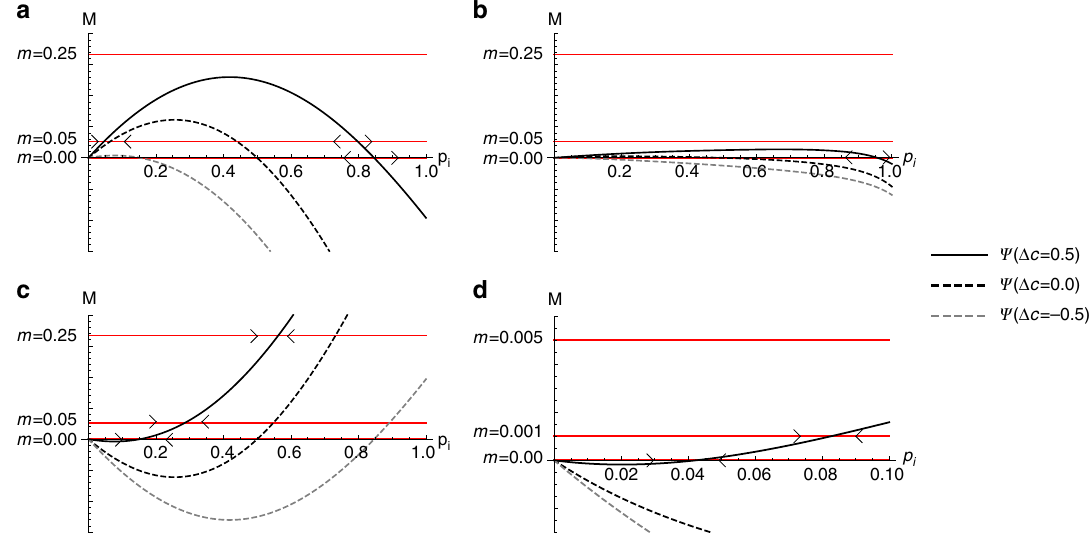
Fig. 4 Equilibrium structure for the scenarios of coordination and complementation. The payoff of a cultural trait increases with its perceived frequency for the coordination scenario ( a , b ) and decreases for the complementation scenario ( c , d ). a , c individuals are equally likely to interact with both types ( X ii = X = X = 1.0); b , d individuals are more likely to interact with individuals of the same type ( X rr ir (red) and the right-hand side (black) of the equilibrium condition M = Ψ ( p i ). Equilibria are present when red and black lines cross; arrows depict the stability of the equilibria (shown only for Δ c = 0.5). In both scenarios, coexistence equilibria are more likely to exist if individuals from different types are relatively likely to interact with each other ( a , c ), and when the resident type is relatively culturally conservative (solid